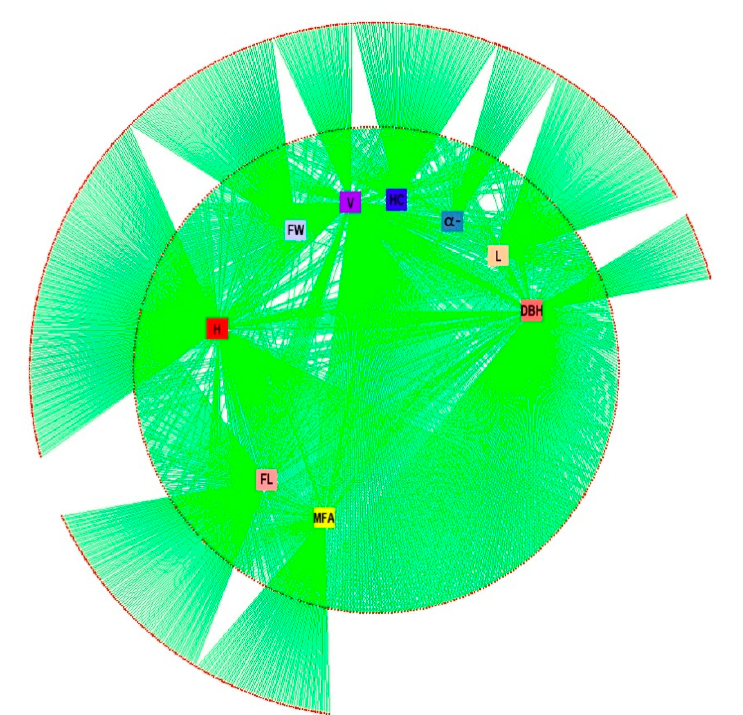
Figure 2. Relationships between all of the significant associated epimarkers and phenotypic traits, as represented by a structural network. The square nodes in the innermost circle represent fiber length (FL), fiber width (FW), microfibril angle (MFA), diameter at breast height (DBH), the height of the tree (H), the volume of timber (V), and the contents of lignin (L), holocellulose (HC) and α -cellulose ( α -). Nodes with red around the central circle represent multi-function associated epimarkers. Nodes with red around the outermost circle represent trait-specific associated epimarkers. The green lines connecting traits with epimarkers represent the phenotype variants explained by the associated epimarkers ( p <